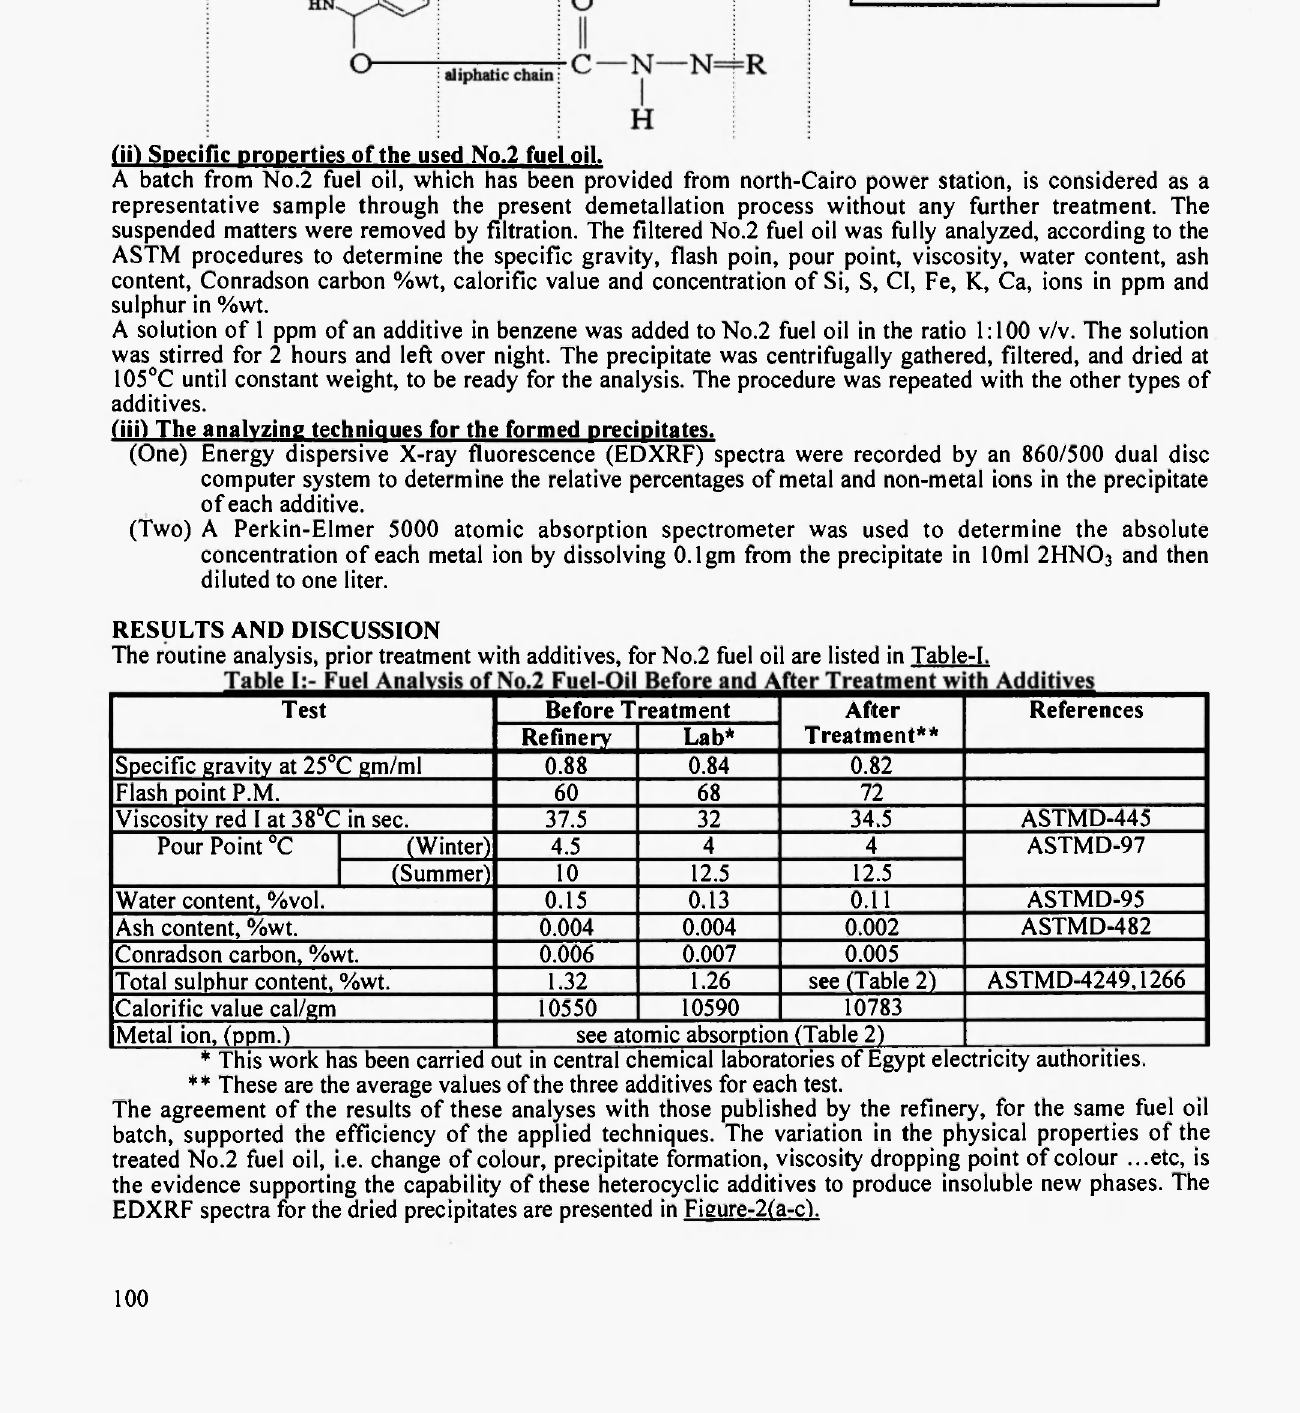
A; R H 2 B; R CCH 3 - CH(CH 3 ) 2 C; R PH-CH